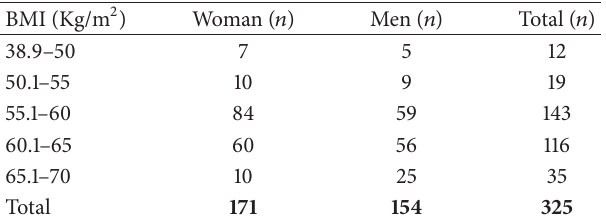
Table 1: Body mass index (BMI) distribution among the study